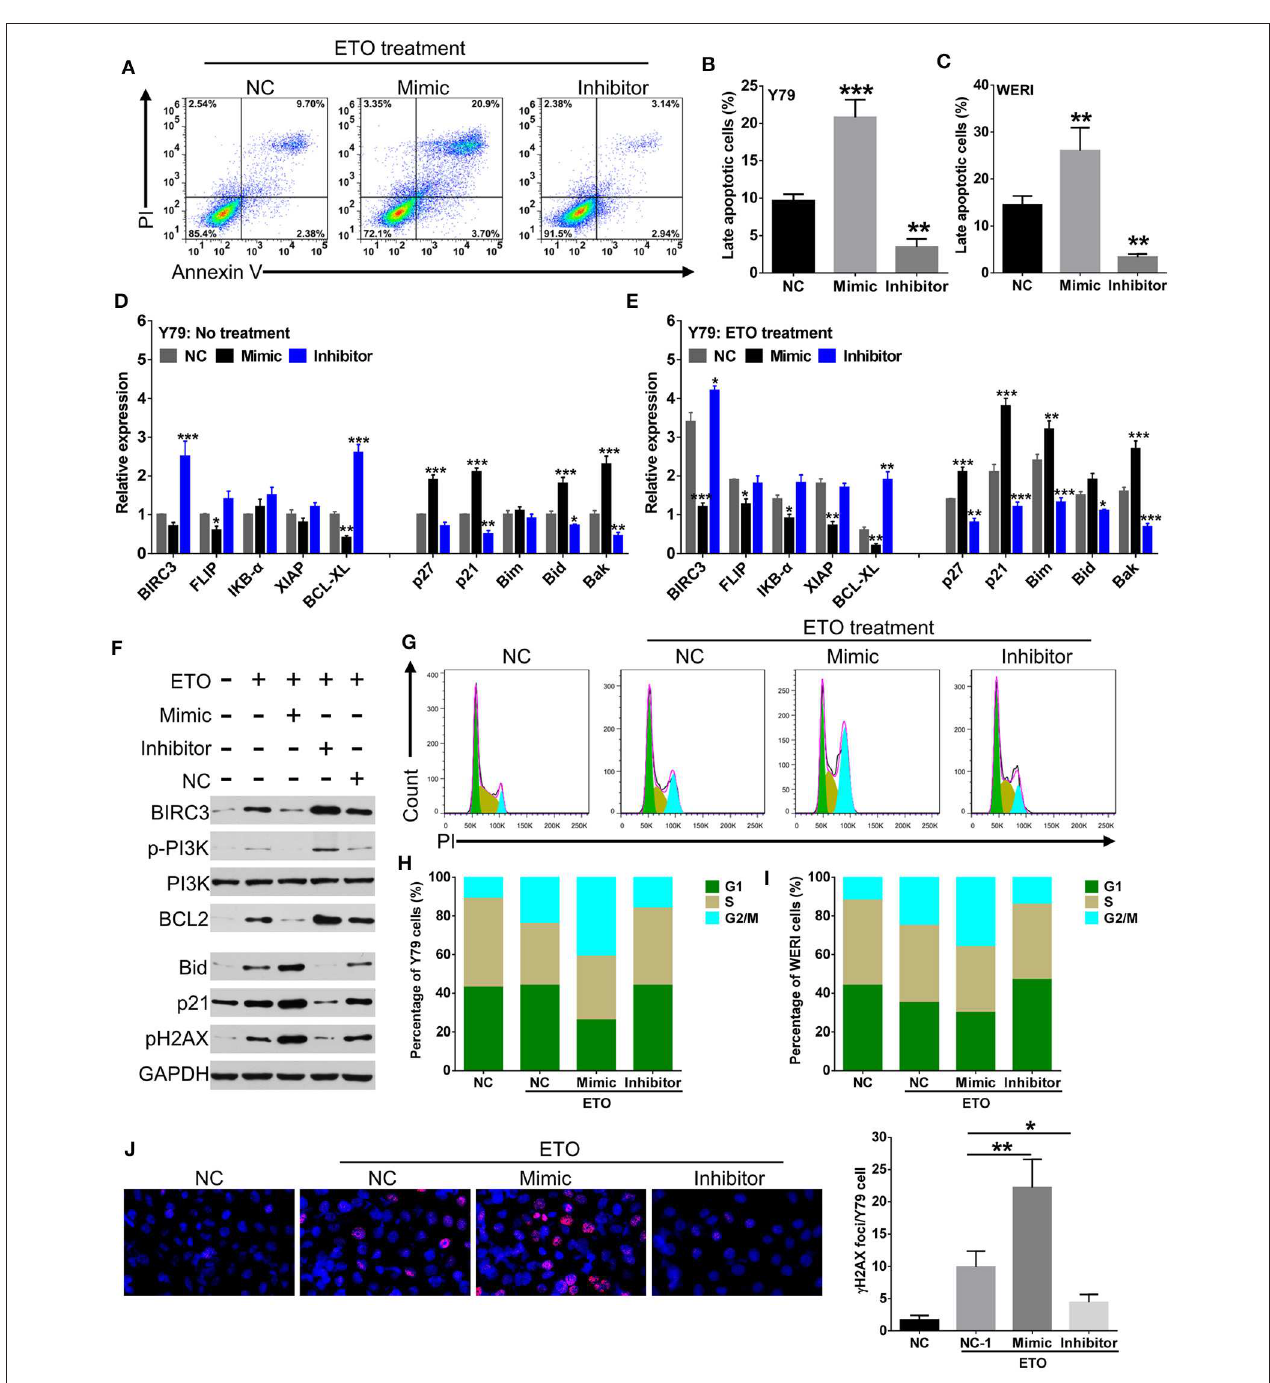
FIGURE 3 | miR-184 enhances apoptosis and G2/M phase arrest of retinoblastoma (RB) cells in response to etoposide (ETO) treatment. (A) Y79 cells with different transfection were treated with ETO (0.25 µ M) for 48h. Cellular apoptosis was detected by flow cytometry. Statistical analysis of the Annexin V + PI + -positive cell ratio in Y79 cells (B) and WERI cells (C) . Same as in (A) , apoptosis-related mRNA expressions in Y79 cells with different transfection alone (D) or additionally treated with ETO (E) were detected by qRT-PCR. (F) Western blot analysis of the expression of apoptosis-related proteins in Y79 cells with indicated treatment same as in (A) . (G) Cell cycle distribution of Y79 cells with treatment same as in (A) was detected by flow cytometry. Statistical analysis of cell cycle phase ratio in Y79 cells (H) and WERI cells (I) . (J) γ H2AX foci in Y79 cells with indicated treatment same as in (A) was detected by immunofluorescence. Statistical analysis of γ H2AX foci in Y79 cells, which were counted in at least 100 randomly selected cells per sample. Data were presented as mean ± SD of three independent experiments. * P < 0.05, ** P < 0.01, *** P < 0.0001 vs. negative control group.